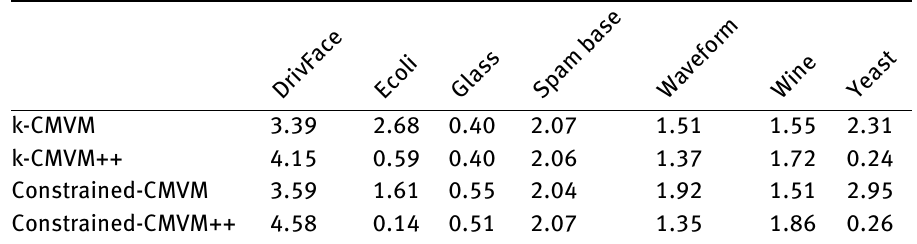
Table 3: Davies Bouldin